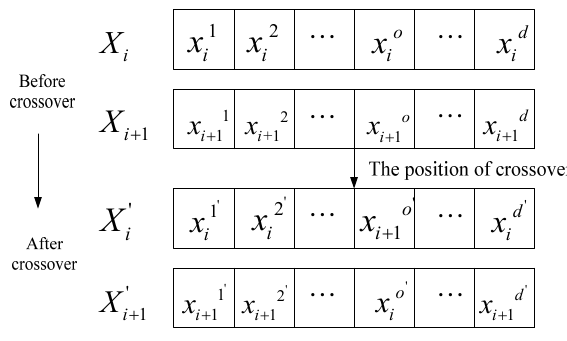
Figure 3. Crossover operation.